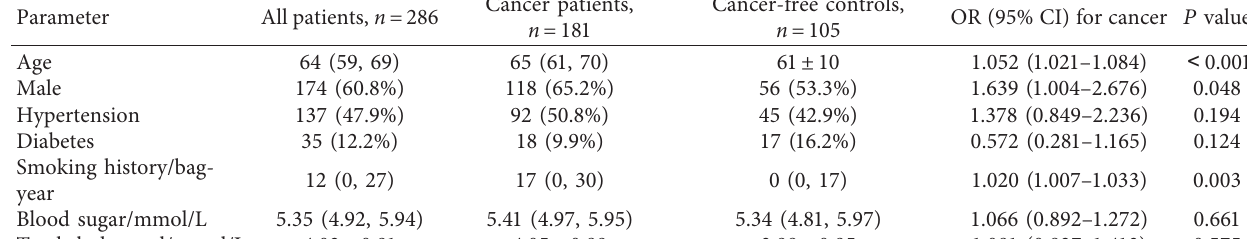
Table 1: Basic characteristics of patients included.